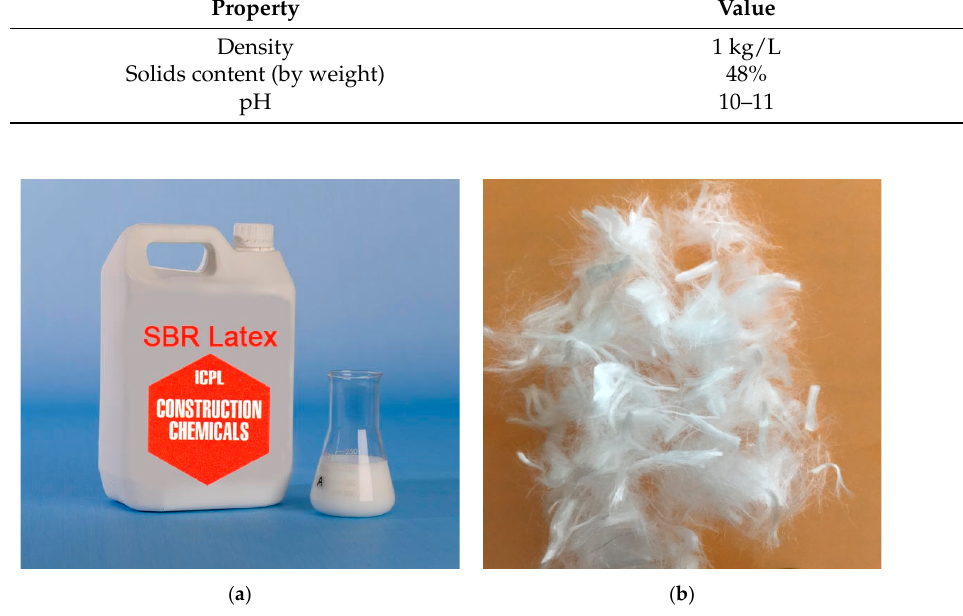
Figure 1. ( a ) SBR latex and ( b ) polypropylene fibers.